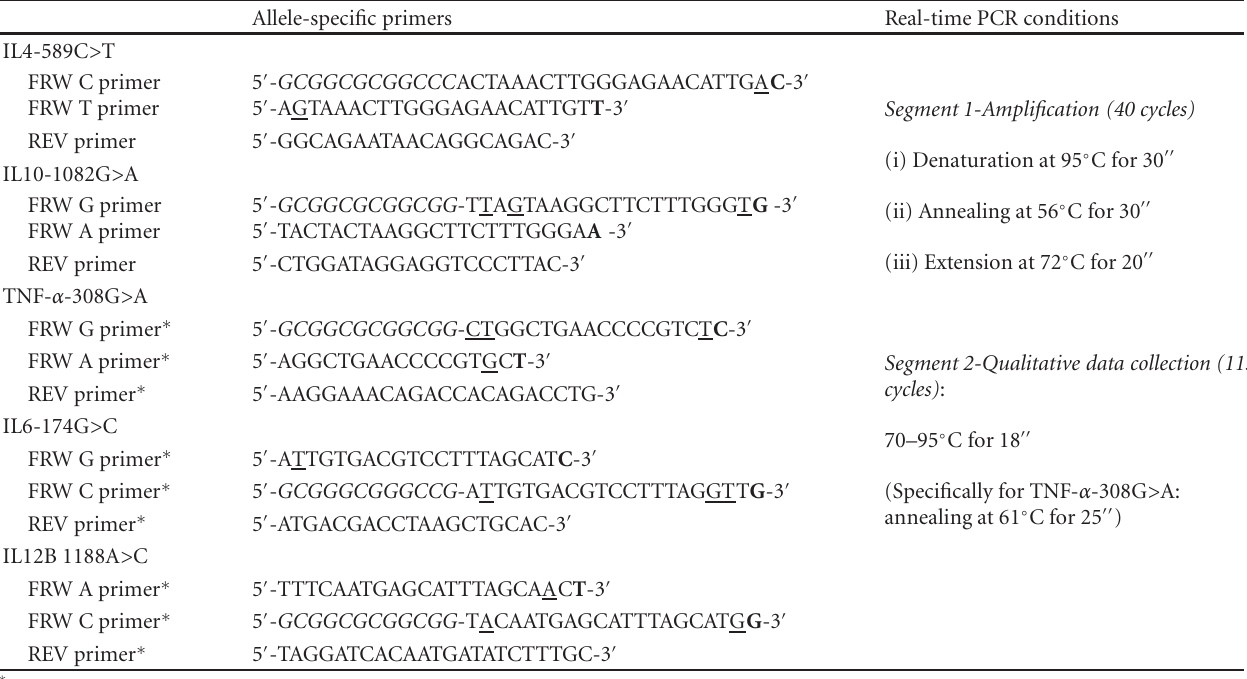
Table 1: Allele-specific primers and real-time PCR